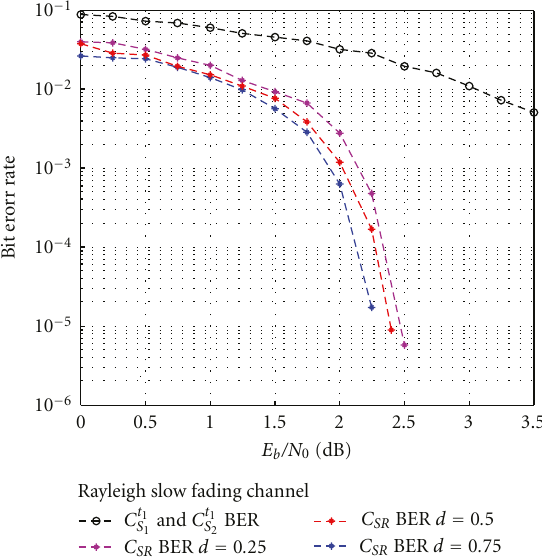
Figure 14: The BER performance under the Rayleigh Slow Fading channel with di ff erent settings of d , the distance between Source and Relay. = R t 1 = 0 . 5. S 1 R S 2 R